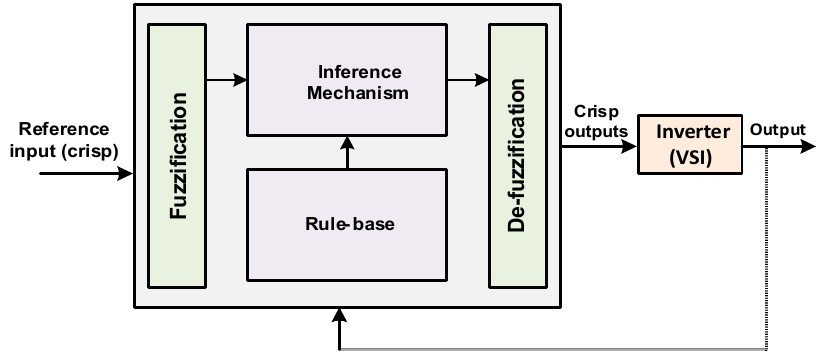
Figure 5. FLC based on the LM optimization algorithm.